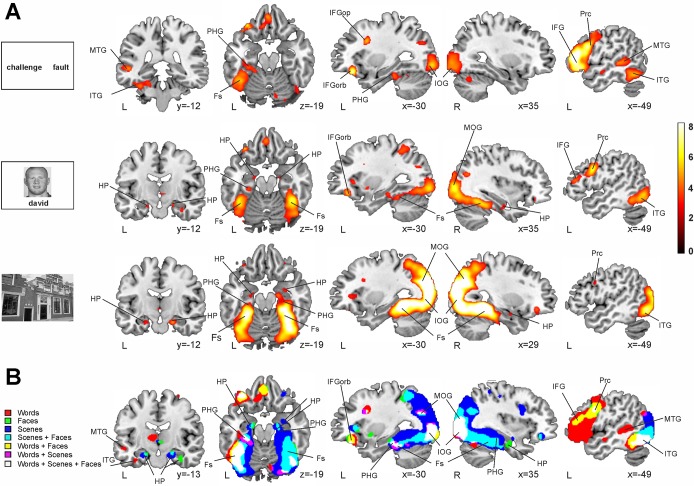
Whole brain material dependent novelty contrast.
A. In red-yellow, enhanced group-level fMRI-signal for the Novel > Repeated encoding trials for words (top), faces (middle) and scenes (bottom). All statistical maps are thresholded at p < 0.05 FDR-corrected with 50 voxels of cluster extent. B. Overlap of the binary images of the novelty encoding effect for the three tasks showing common areas of activation. Neurological convention is used. Contrasts are overlaid over a canonical template with MNI coordinates at the bottom right of each slice. HP, hippocampus; PHG, parahippocampal gyrus; Fs, fusiform gyrus; Post, postcentral gyrus; IFGorb, inferior frontal gyrus pars orbitalis; IFGop, inferior frontal gyrus pars opercularis; MOG, middle occipital gyrus; IOG, inferior occipital gyrus; Prc, precentral gyrus; IFG, inferior frontal gyrus; ITG, inferior temporal gyrus; MTG, middle temporal gyrus; L, Left Hemisphere; R, Right Hemisphere.